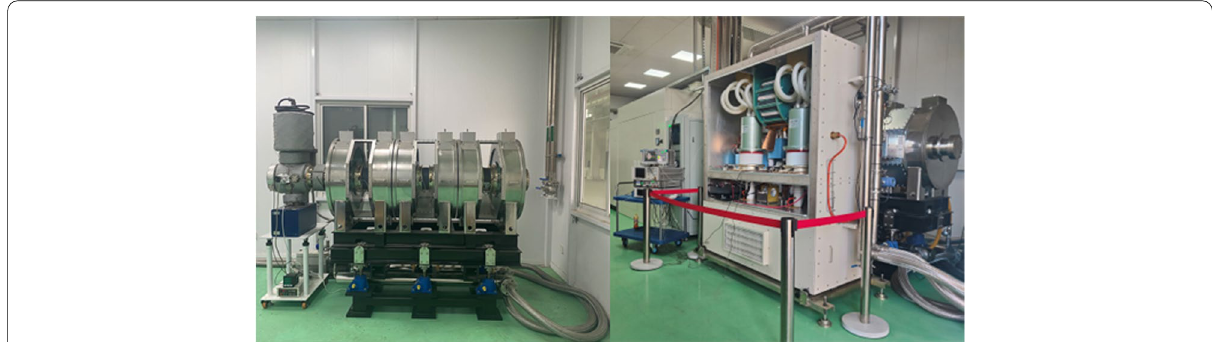
Fig. 5 Left, the magnetic alloy acceleration cavity. Right, the cavity coupled to a power source under test in a vacuum of 5.5